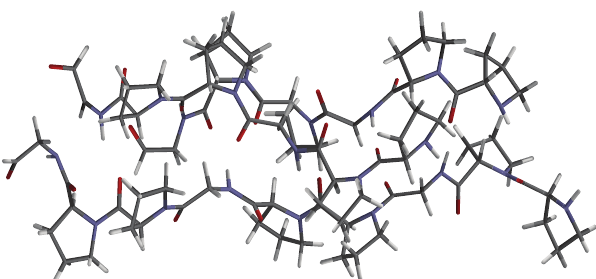
Figure 2: Structure of collagen. The red color represents the oxygen atom; blue: nitrogen, gray: carbon, and white: hydrogen.